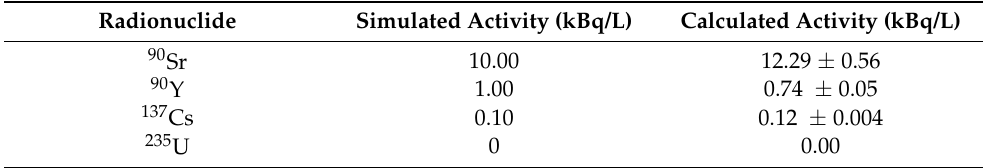
Table 4. The estimate of 90 Sr , 90 Y and 137 Cs activity from a realistic groundwater borehole.